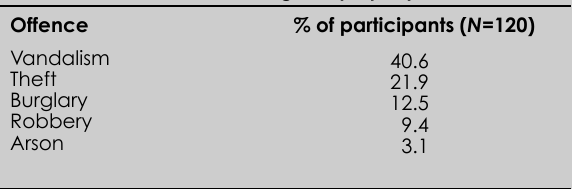
Table III. Offences committed against property